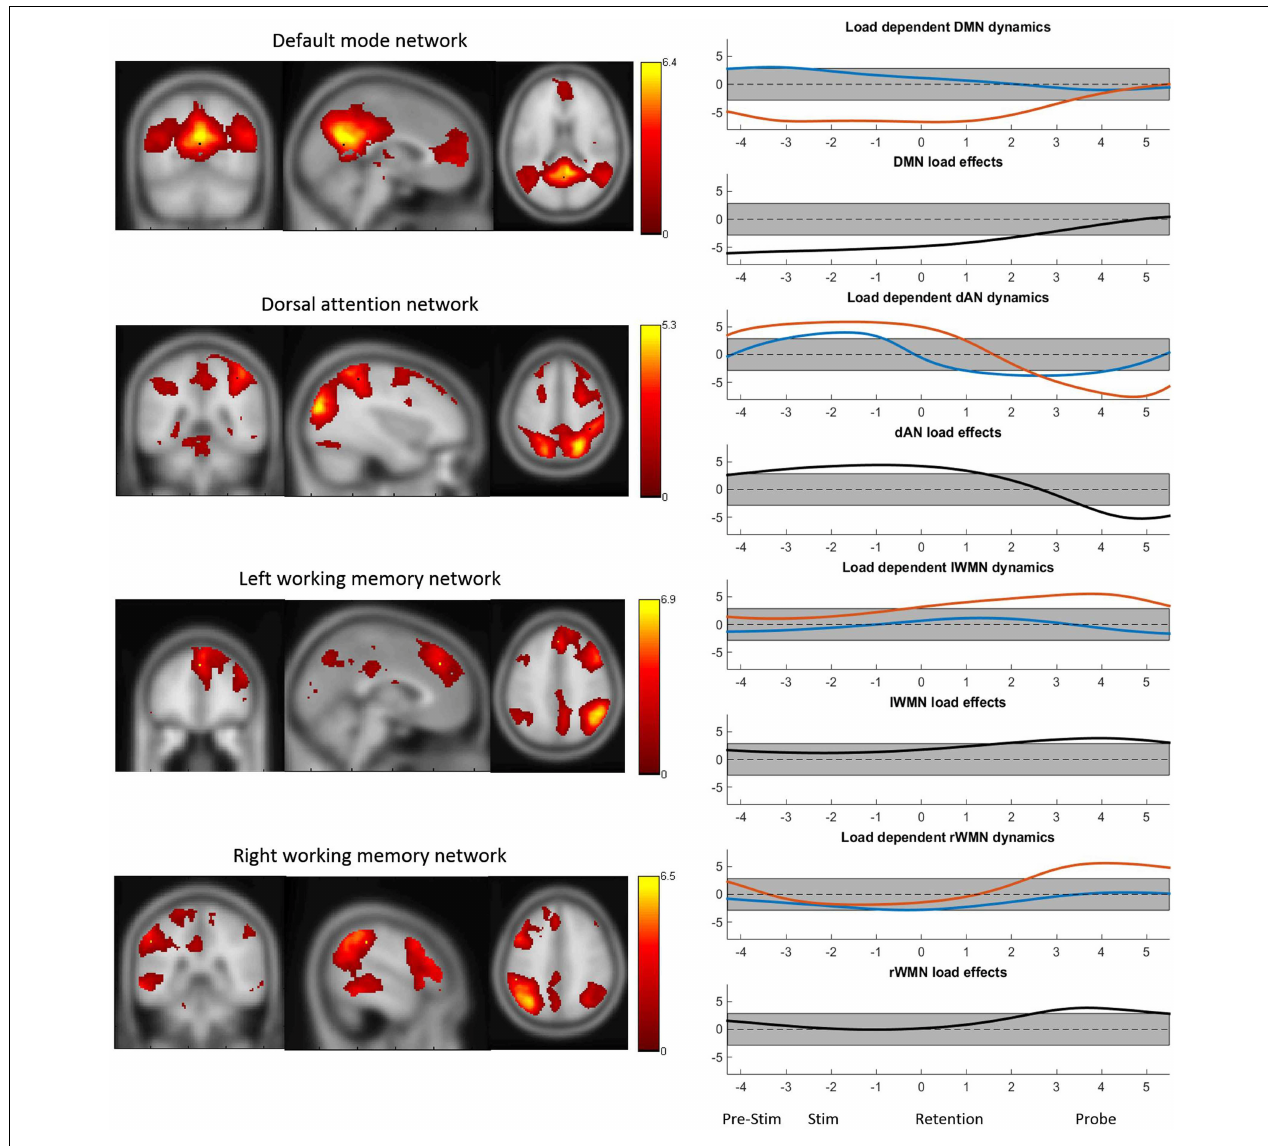
represent t -values and the gray bar represents the significance-threshold. The x-axis represents the time in seconds: − 4 to − 2.2: pre-stimulus; − 2.5 to 0: stimulus; 0 to 3.5: retention; 3.5 to 5.5: probe; 5.5 to 5.8 and − 4 to − 2.5: pre-stimulus. 0 marks the beginning of the retention